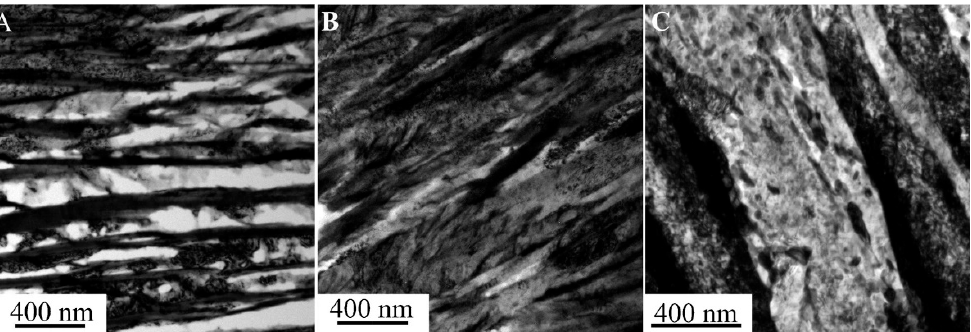
Figure 6. Bright field image of 0.82C–1.66Si–2.05Mn–0.22Cr–0.36Mo–1.06Ni steel. ( a ) Base material; ( b ) low-energy welding process; ( c ) high-energy welding process. Images produced via TEM [21].